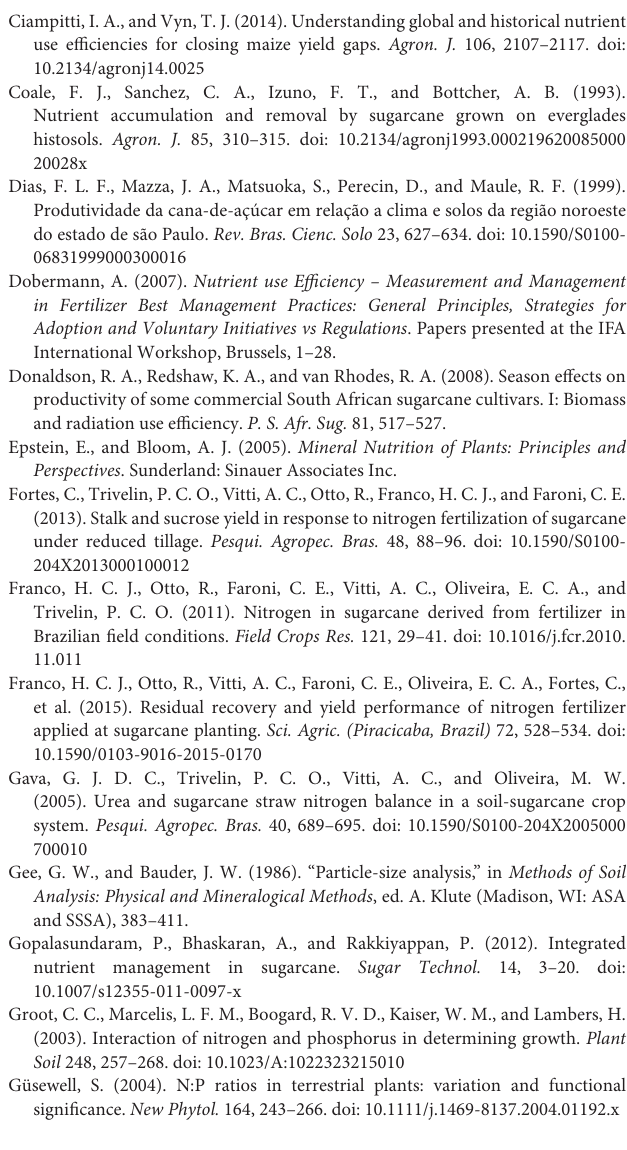
FIGURE S1 | Relationships between nitrogen (N) versus potassium (K) content for all plant components: aboveground biomass (A), dry leaves (B), tops (C), and stalks (D). Each data point represents an individual field plot at sugarcane harvest of a first ratoon growing season for three site-years ( n = 102). Dotted lines show boundary ratios for each component between N versus K, and black line shows the average value. TABLE S1 | Mean value of biomass accumulation, nutrient (N, P, and K) content, and nutrient ratios (N:P and N:K) in the stalks, dry leaves, tops, and total aboveground part of sugarcane (first ratoon cycle) across three sites located in the Southeast region of Brazil ( n = 4 for Sites 1 and 2; n = 5 for Site